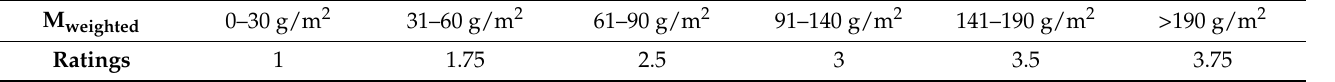
Table 1. RDS mass per unit area ranking